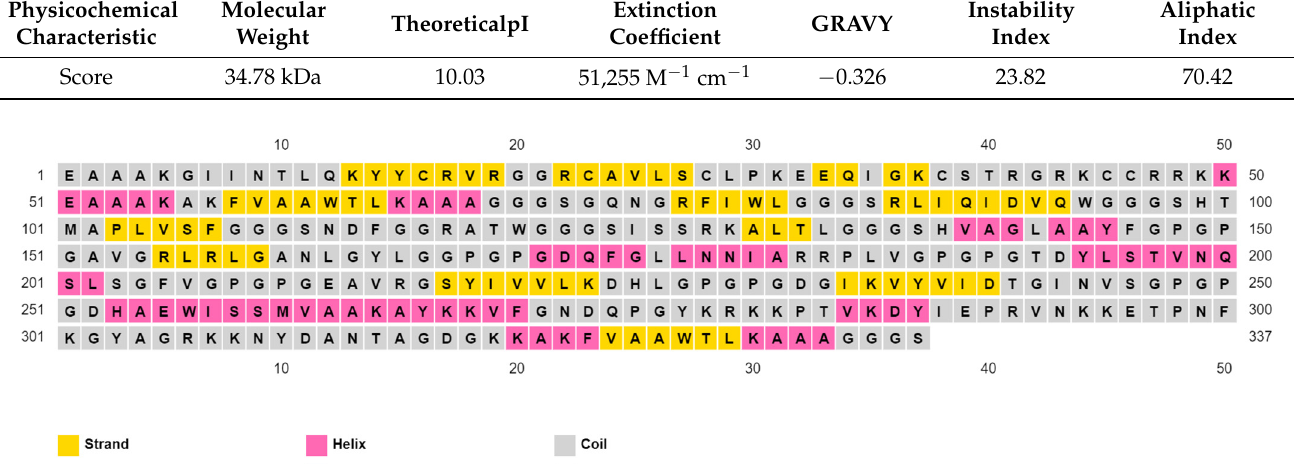
Figure 5. PESIPRED server output for the multitope vaccine secondary structure estimation.